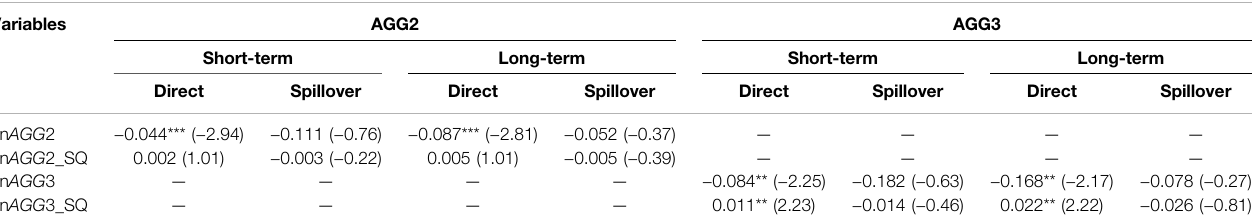
TABLE 7 | The estimated results of the agglomeration by industry.